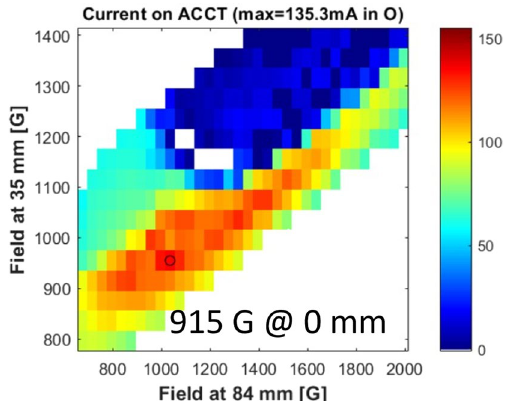
Figure 3. ACCT current measured around the standard MDIS configuration; colour scale proportional to the mean produced beam current in mA.